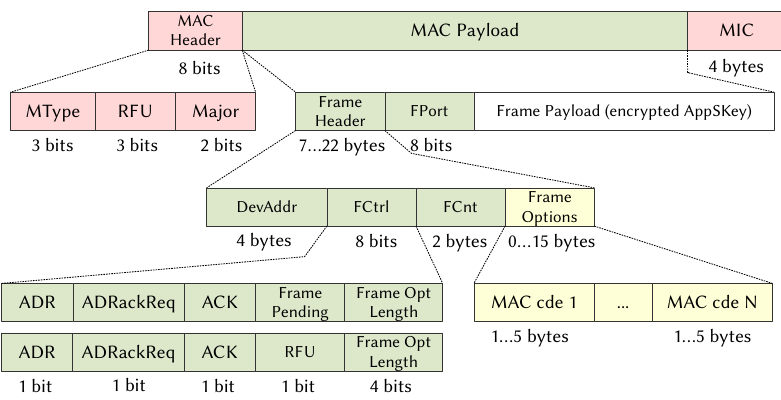
Figure 7. LoRaWAN MAC Protocol Data